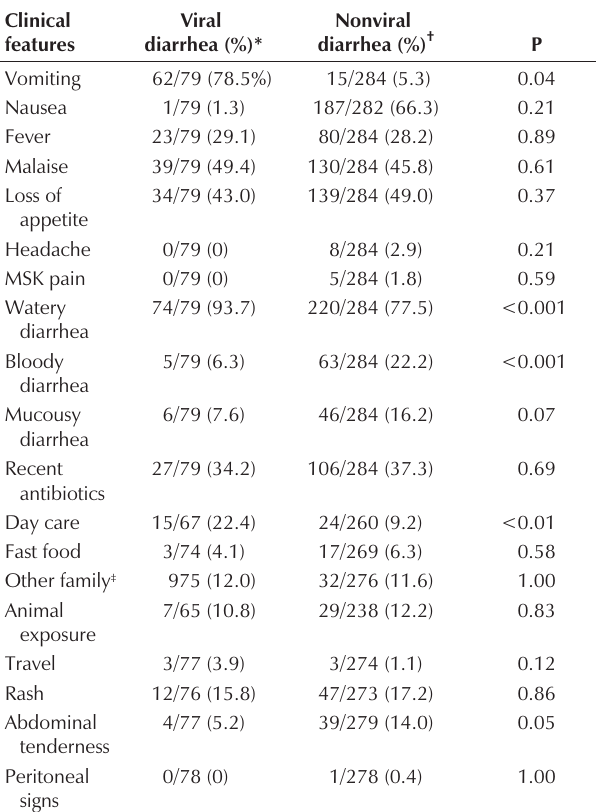
Clinical features of bacterial community-acquired diarrhea at the Alberta Children’s Hospital, Calgary, Alberta from April 1,